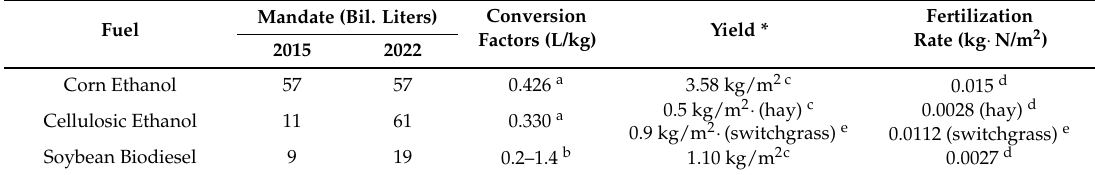
Table 3. SPARROW calibration results of sources of nitrogen, delivery and decay